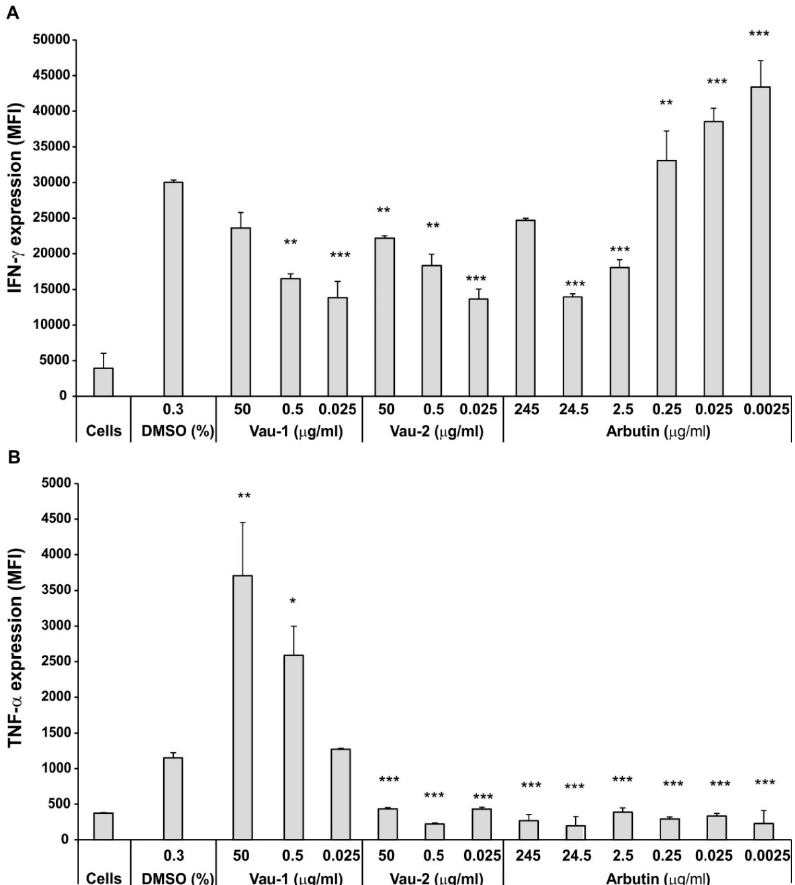
Figure 3. Effect of Vau-1/Vau-2 or arbutin on production of cytokines IFN- γ ( A ) and TNF- α ( B ) . Purified neutrophils were cultured in the presence of DMSO (0.3%) and decreasing concentrations of Vau-1, Vau-2 and arbutin for 36 h. Control cells were incubated with phosphate-buffered saline (cells). In the last 4 h of incubation, the neutrophils were stimulated with PMA / Yon in the presence of the Golgi inhibitor, monensim, in order to maximize cytokine accumulation. The neutrophils were then washed and stained for the neutrophil marker, Ly6G. The cells were then fixed, permeabilized and incubated with PE / Cy7 or APC / Cy7 conjugated antibodies against TNF- α and IFN- γ . After washing, gated Ly6G + cells were subjected to flow cytometry analysis for the intracellular production of cytokines. Data represent mean ± SD of sample from 2 experiments with neutrophils isolated and pooled from 7 mice and assayed in duplicate. P-values are shown for each group when compared to the